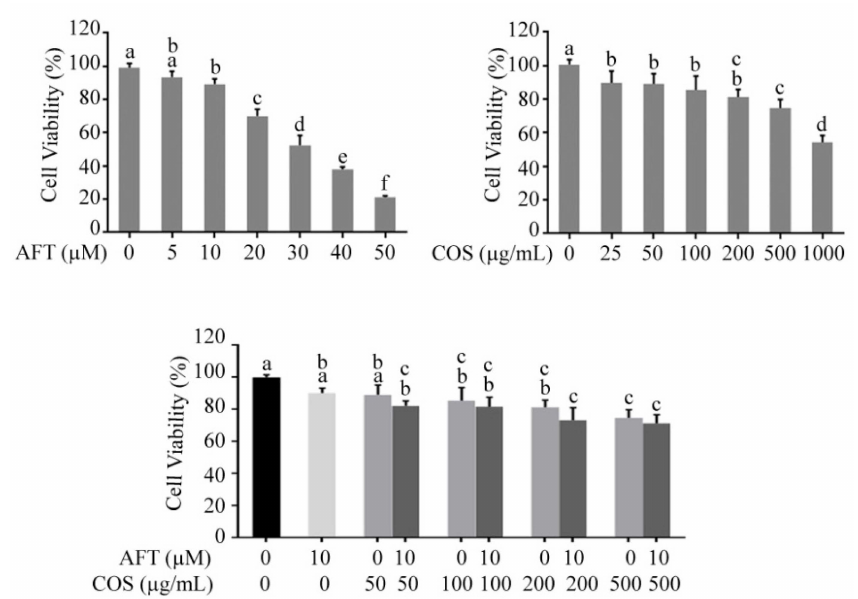
Figure 6. The effect of COS on the anti-cancer activity of afatinib. The effect of afatinib or COS either alone or in combined treatment on the cell viability of T84 cells. Data were expressed as the mean ± SD of five independent experiments. Columns not sharing the same superscript letters differ significantly ( p <